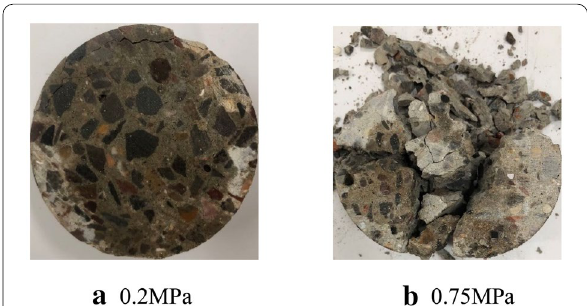
Fig. 6 Failure modes of NC specimens under different impact